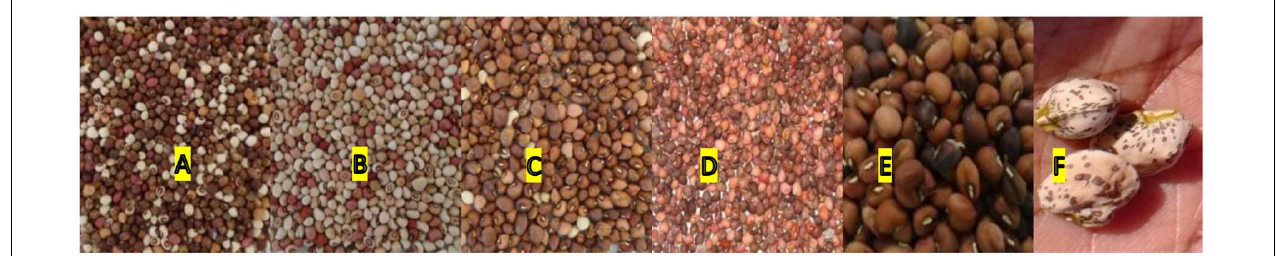
FIGURE 4 | Different M 3 seed colors (A–F) observed among all mutants at all locations.